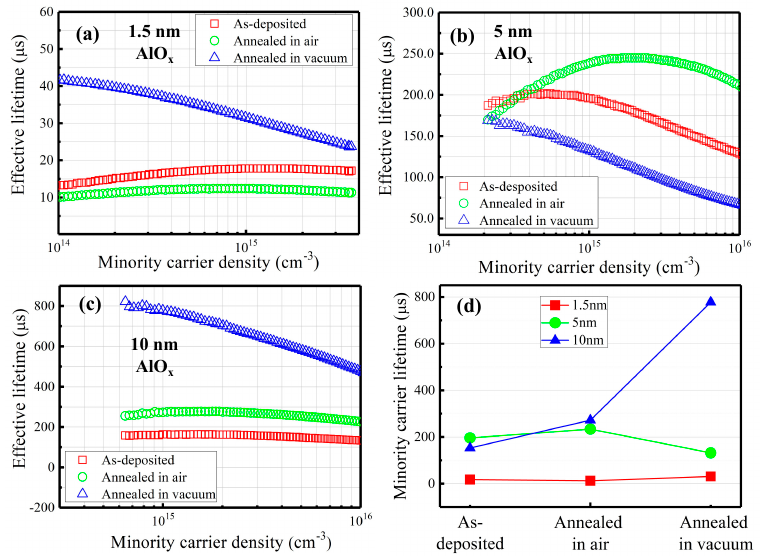
Figure 1. Minority carrier lifetime as a function of the minority carrier density for symmetrical deposition of AlO x with three different thicknesses: ( a ) 1.5 nm, ( b ) 5 nm, ( c ) 10 nm. ( d ) Summary of effective carrier lifetime upon different thermal treatments.